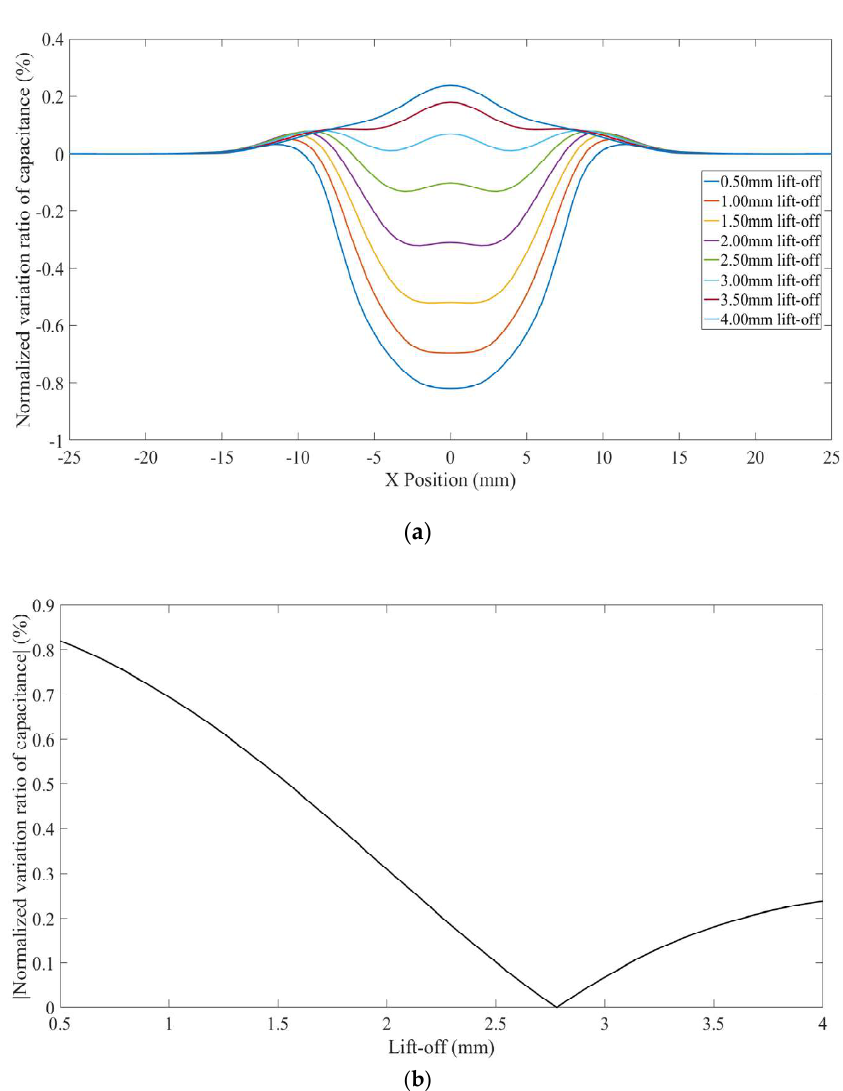
Figure 11. ( a ) NVR curves for Model 5 with lift-offs increased from 0.5 mm to 4 mm and ( b ) absolute values of the NVRs at the centre point against lift-offs.